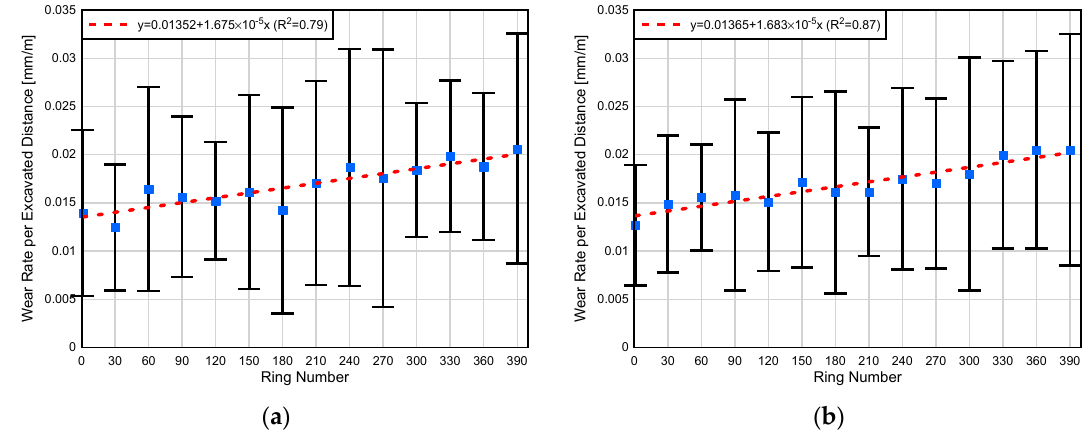
Figure 10. Wear rate of slurry pipes with respect to position: ( a ) TBM No. 1; ( b ) TBM No. 2.